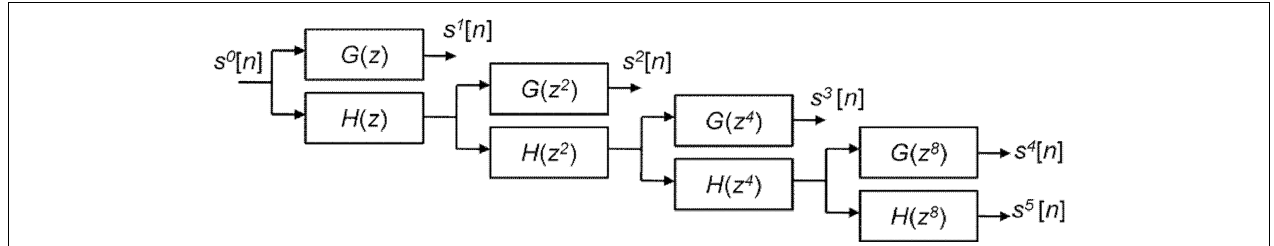
FIGURE 2 | Decomposition of discrete signal s 0 [ n ] using 4-scale SWT.